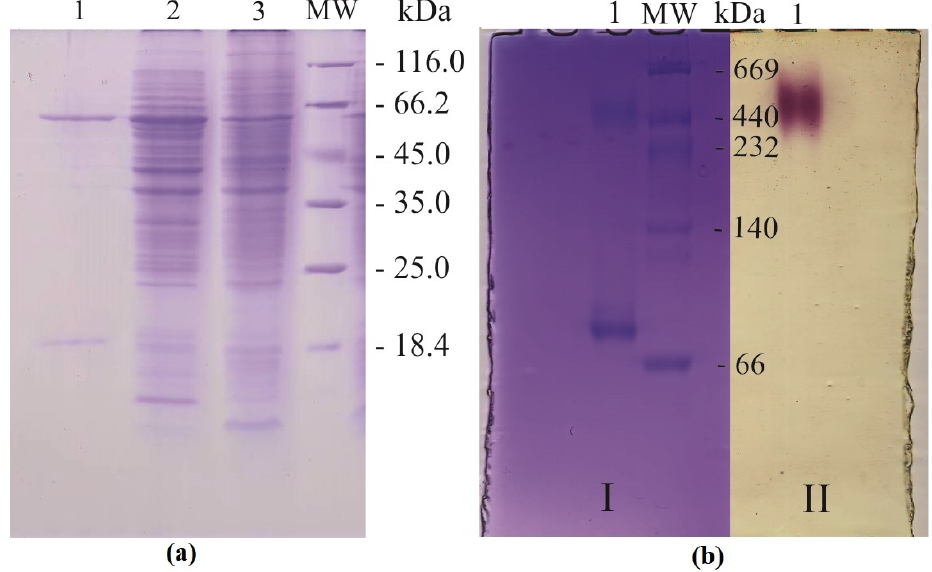
Figure 2. ( a ) SDS-PAAG electrophoresis of the purified recombinant protein MDH-His 6 -tag and supernatant of recombinant and wild-type strains of M. extorquens . The concentration of the separating gel was 12%, SDS was added to 0.1% concentration. 1—purified enzyme, 2—supernatant of M. extorquens pCM160::mxaF, 3—supernatant of M. extorquens AM1, MW—molecular weight markers (Unstained Protein MW Marker, Thermo Fisher Scientific, USA). ( b ) Native PAAG with 5–12% concentration gradient. (I) 1—purified enzyme, MW—molecular weight markers (High MW Native Marker Kit, GE Healthcare, USA); (II) Visualization of MDH activity. Methanol dehydrogenase activity was detected using nitroblue tetrazolium and phenazine methosulfate in the presence of 20 mM methanol and 15 mM ammonium chloride.